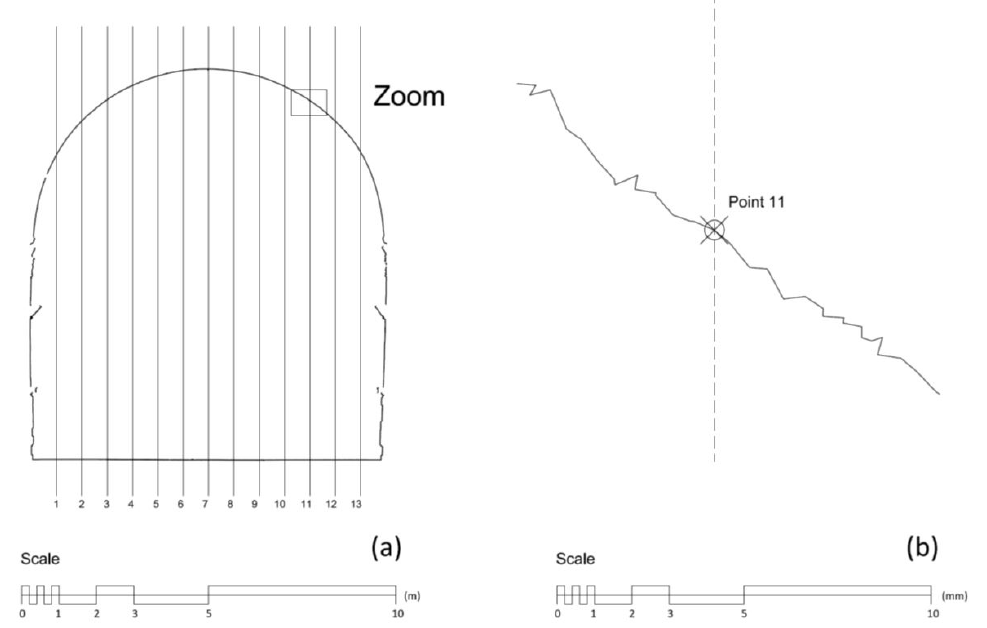
Figure 7. Graphic representation of standard arch coordinates points offered in Table 4 ( a ) the arch is divided in 14 equidistant sections including the key ( b ) a point zoom of the lower arch path to obtain the coordinates (x,y) with the AutoCad